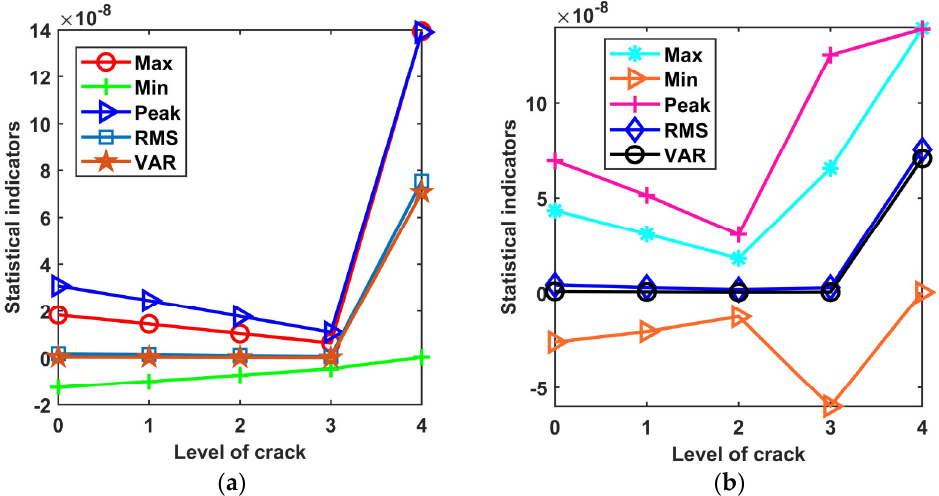
Figure 13. Statistical indicator curves. ( a ) Different crack depths. ( b ) Different crack angles.